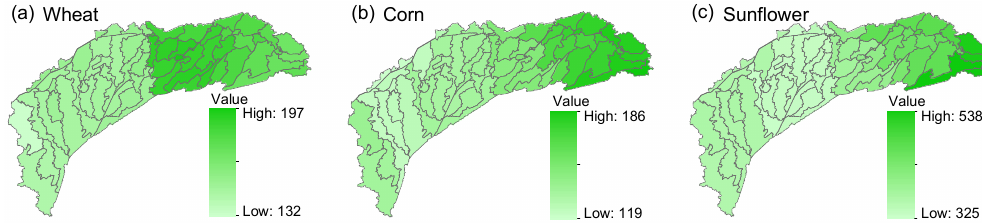
Figure 7. The spatial distribution of the green water footprint of crop production in the HID (m 3 t − 1 ).